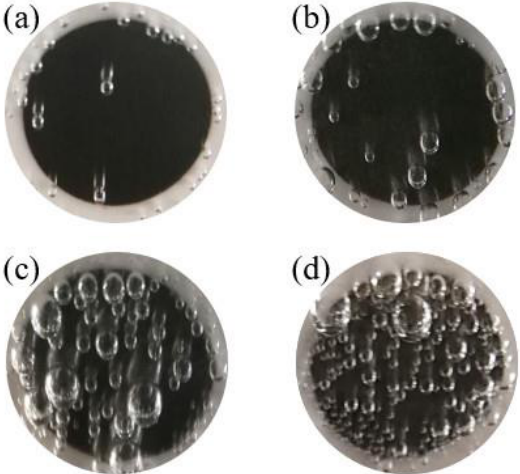
Figure 9. Optical photograph of Q345R steel in 1wt.% NaCl solution at 30 °C, 0.08 mg/L oxygen, −0.9V vs. SCE: ( a ) pH 4.0; ( b ) pH 3.0; ( c ) pH 2.5; and ( d ) pH 2.0.